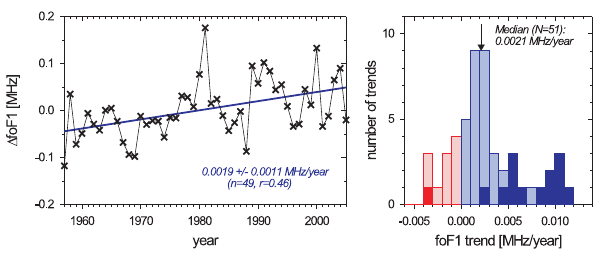
Fig. 9. Global mean foF1 trend (left part) and histogram (right part) deduced from observations at 51 individual ionosonde